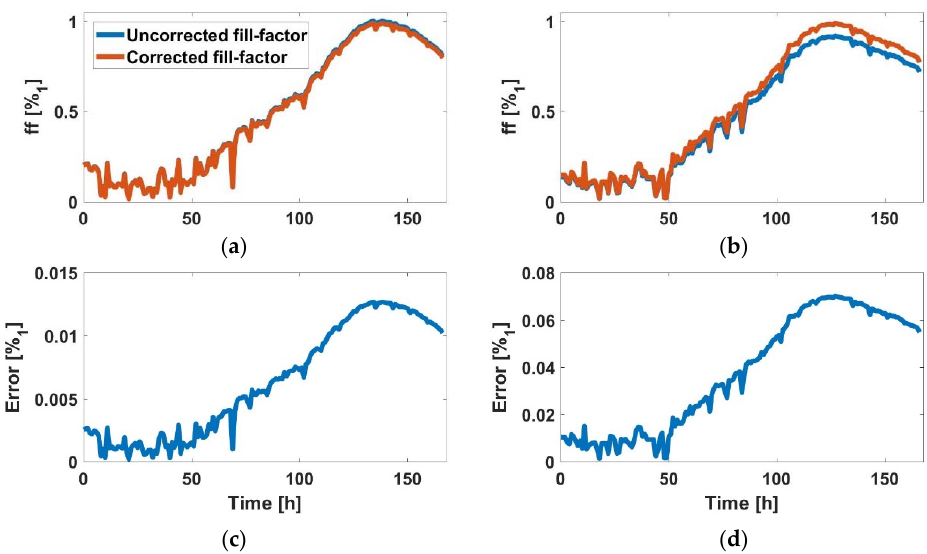
Figure 6. ( a ) Comparison between uncorrected and corrected ff , and ( b ) ff estimation error (AA8 with 2500 cells at the beginning). ( c ) Comparison between uncorrected and corrected ff , and ( d ) ff estimation error (AA8 with 5000 cells at the beginning).